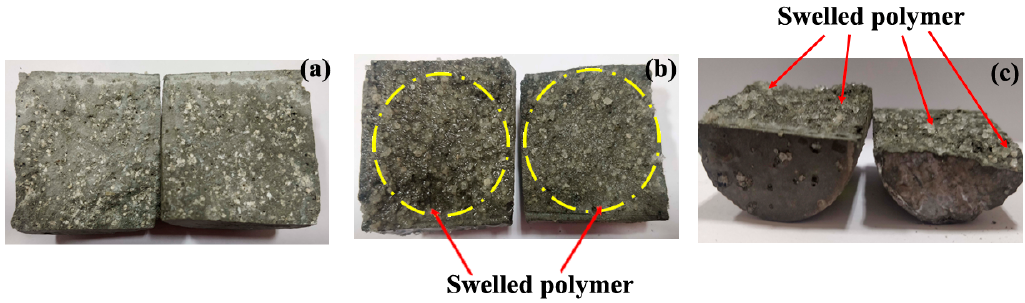
Figure 14. Snapshots of split cement core ( a ) before ( b – c ) after water absorption.